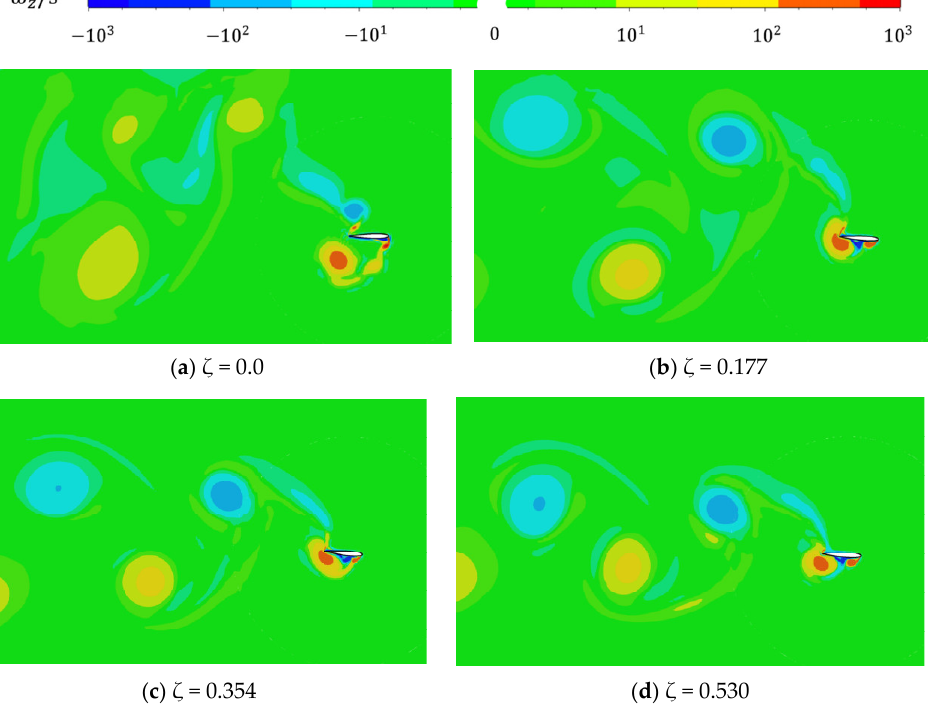
Figure 8. Wake vortex diagrams of the flapping hydrofoil with four damping coefficients in baseline case: ( a ) ζ = 0.0; ( b ) ζ = 0.177; ( c ) ζ = 0.354; ( d ) ζ = 0.530 (the time selected is when the pitch angle is zero).